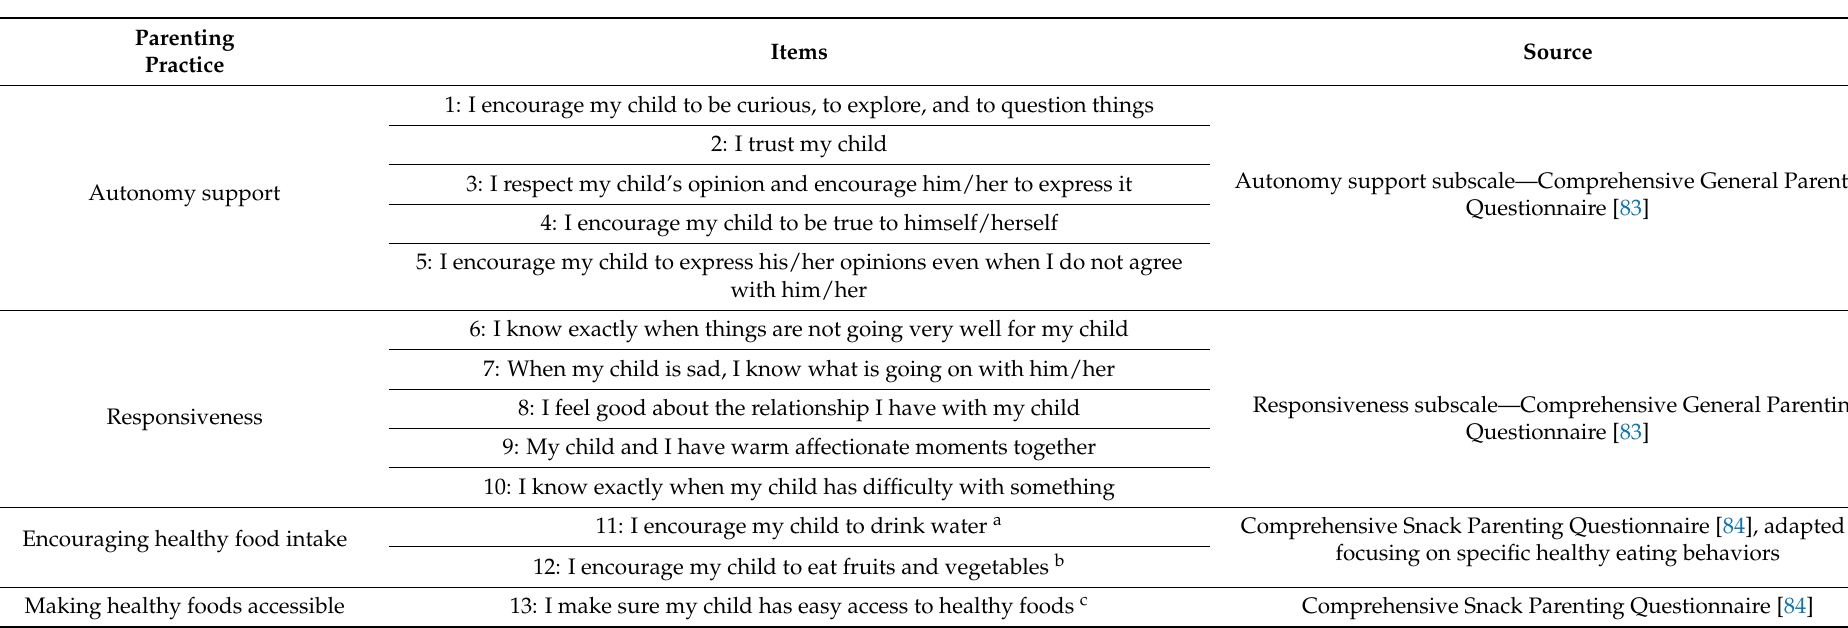
Table 1. Supportive parenting practices for food-related autonomy and